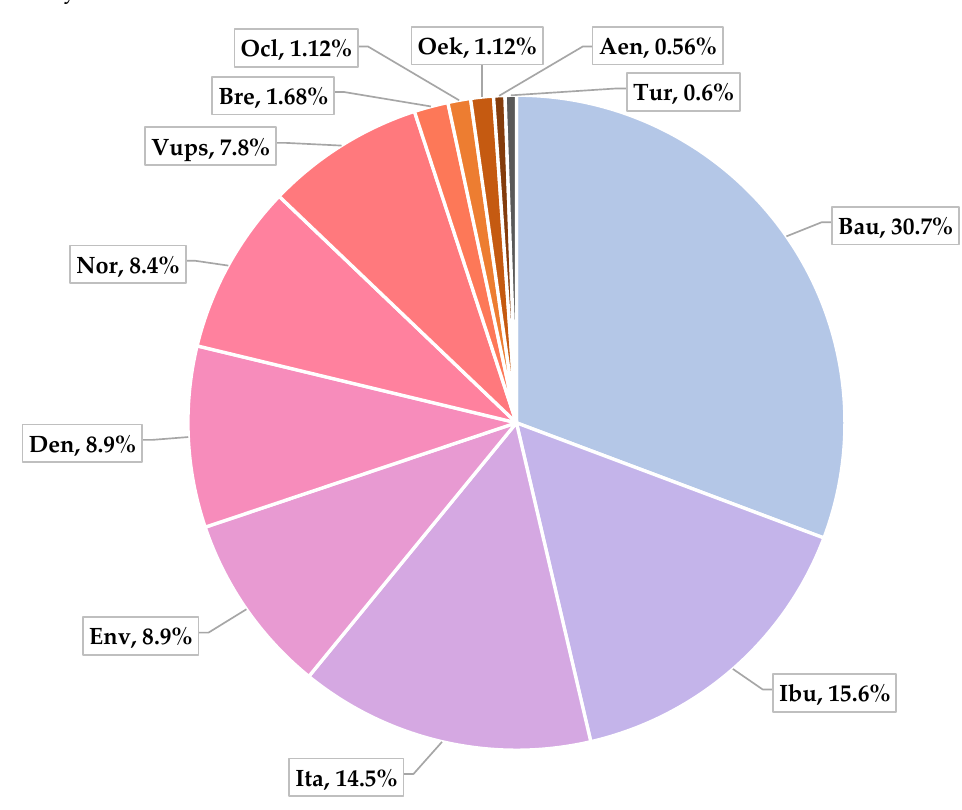
Figure 2. Share of the various program operators in the total amount of analyzed data. The Baubook (30.7%), IBU (15.6%), EPD Italy (14.5%), Environdec (8.9%), and EPD Denmark (8.9%) databases represent the major data sources, making up approximately 78.6% of the whole sample.